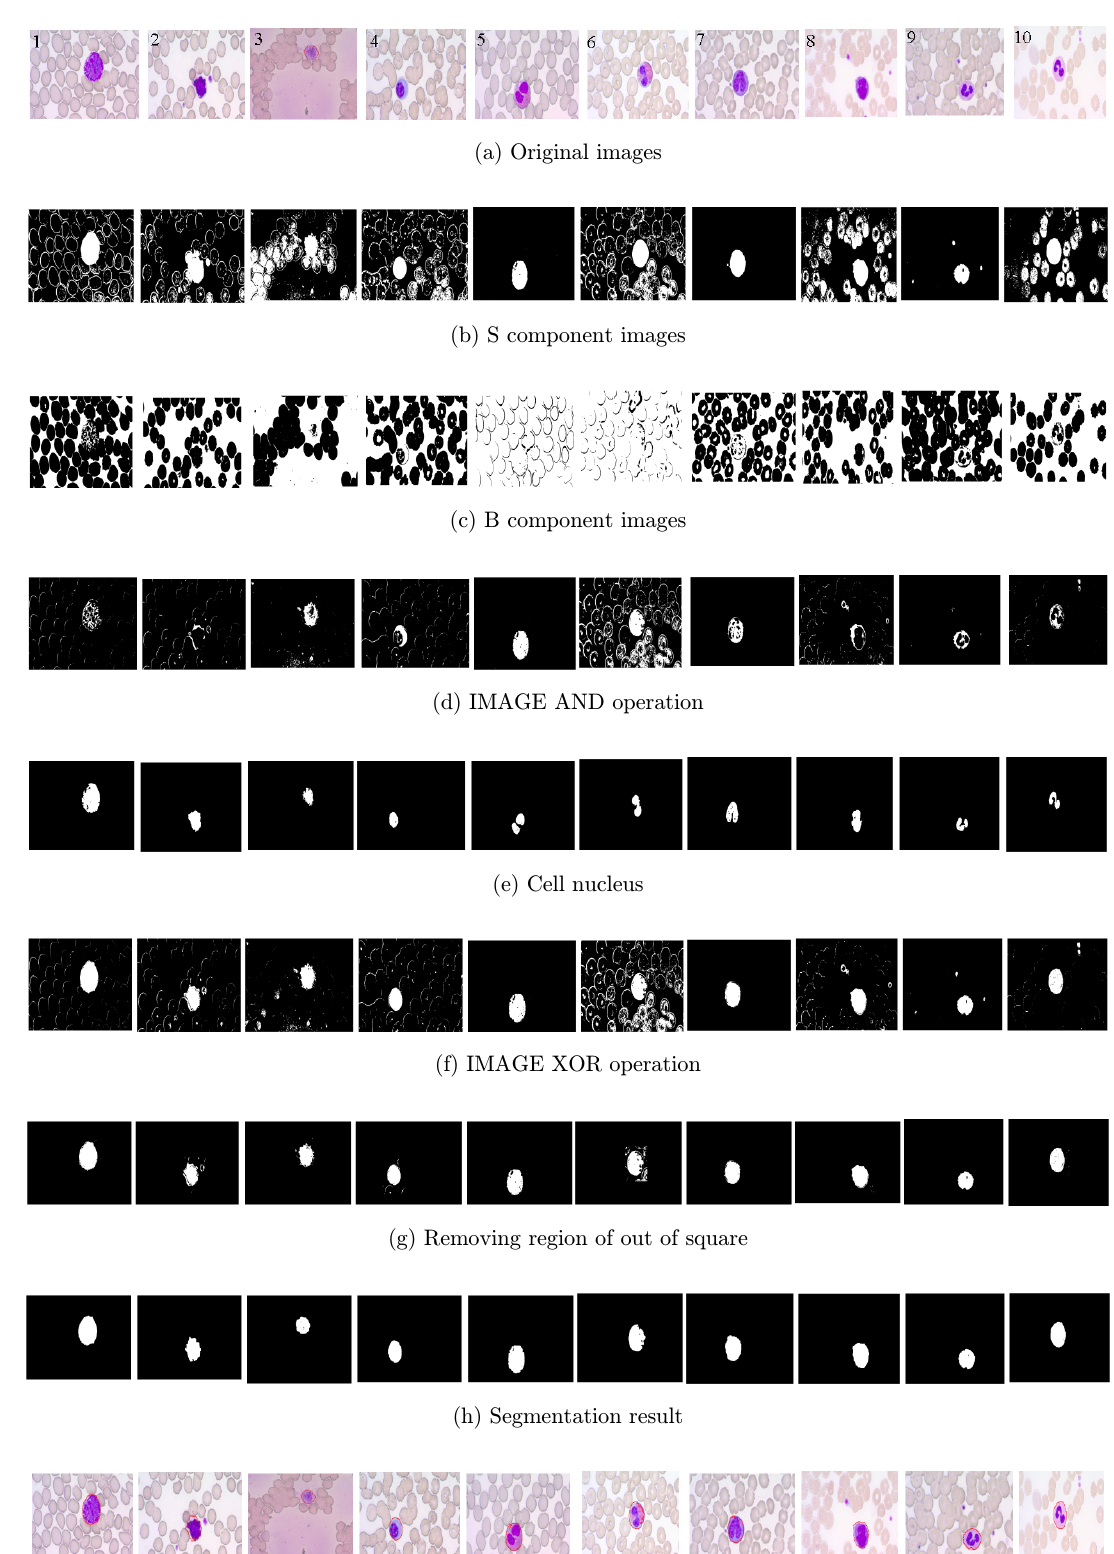
Fig. 4. Experiment